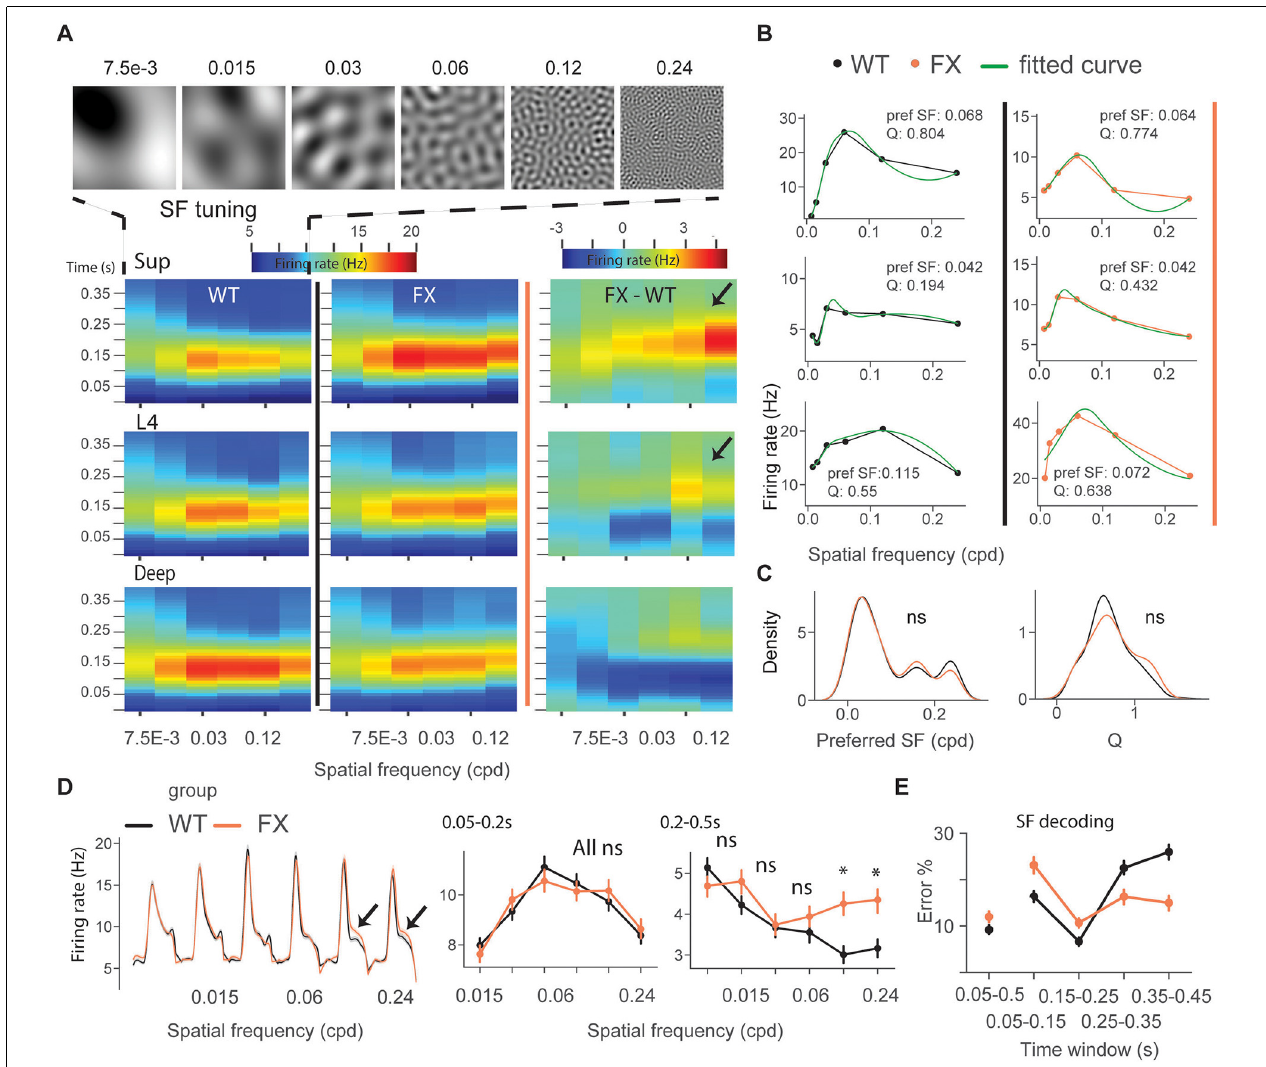
FIGURE 3 | Excessive processing of high SF stimuli in late responses of single units in FX mice. (A) Time-course analysis of SF tuning across the cortical layers. Unit responses for different SF stimuli were plotted for each time step to create the heatmaps for WT (left), FX (middle), and FX-WT (right). (B) SF tuning curves were computed by averaging responses within 0.05–0.2 s relative to the stimulus onset and fitted using Difference-of-Gaussians. Example plots are shown for WT (left) and FX mice (right). (C) Distribution of preferred SF (left) and Q-factor (right) for both groups. The larger Q values indicate sharper tuning. (D) Population average firing rates of all units in response to the SF tuning sequence. Note enhanced late part responses at higher SF. The population mean SF tuning responses were averaged for different time intervals. 0.05–0.2 (left) and 0.2–0.5 s (right). (E) Population spike counts from different time windows were used for SF neural decoding. The classifiers that were trained on responses after 0.25 s relative to stimulus onset had a lower error in FX vs. WT mice. ∗ p < 0.05, ns = not significant.